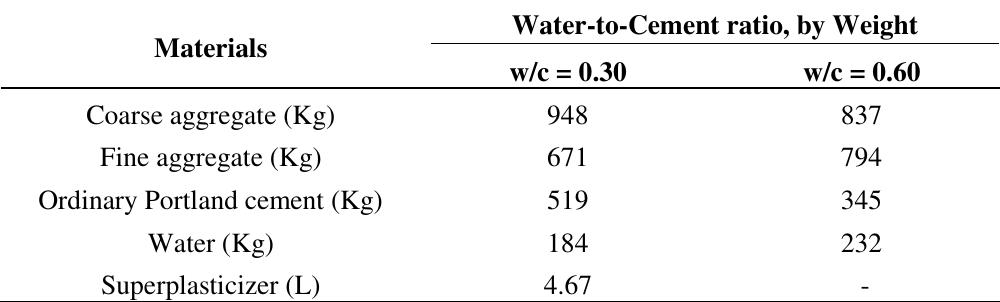
Table 4. Mixture proportions used to prepare 1 m 3 of